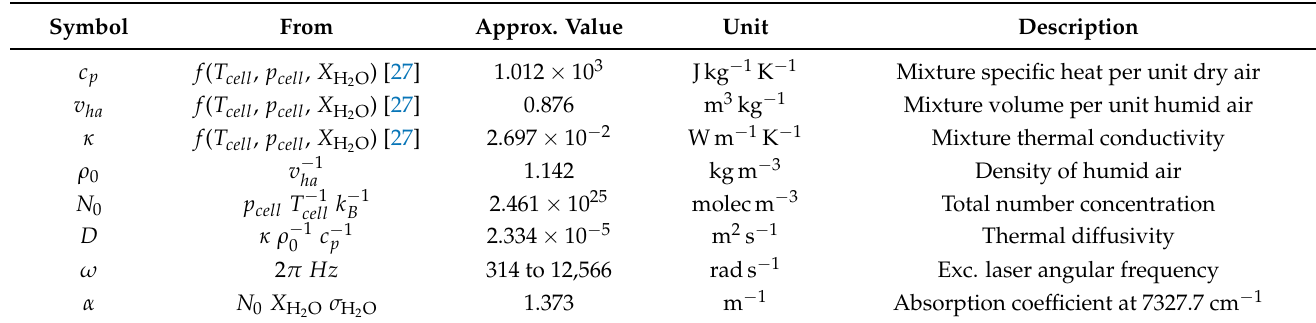
Table A2. Listing of the secondary parameters for the calculation of the theoretical temperature amplitude ∆ T , derived from Table